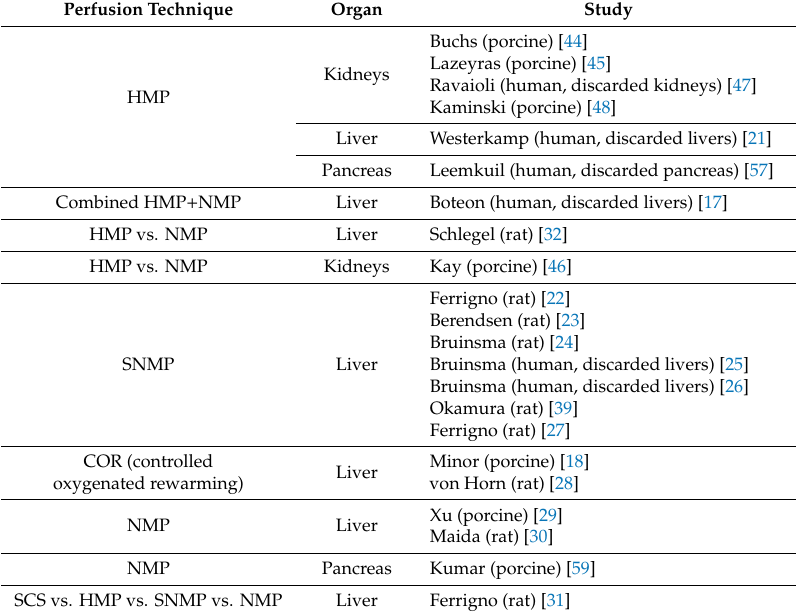
Table 10. Preclinical and animal MP studies that reported ATP or ATP-related parameters as one of the end points (2009–2019).